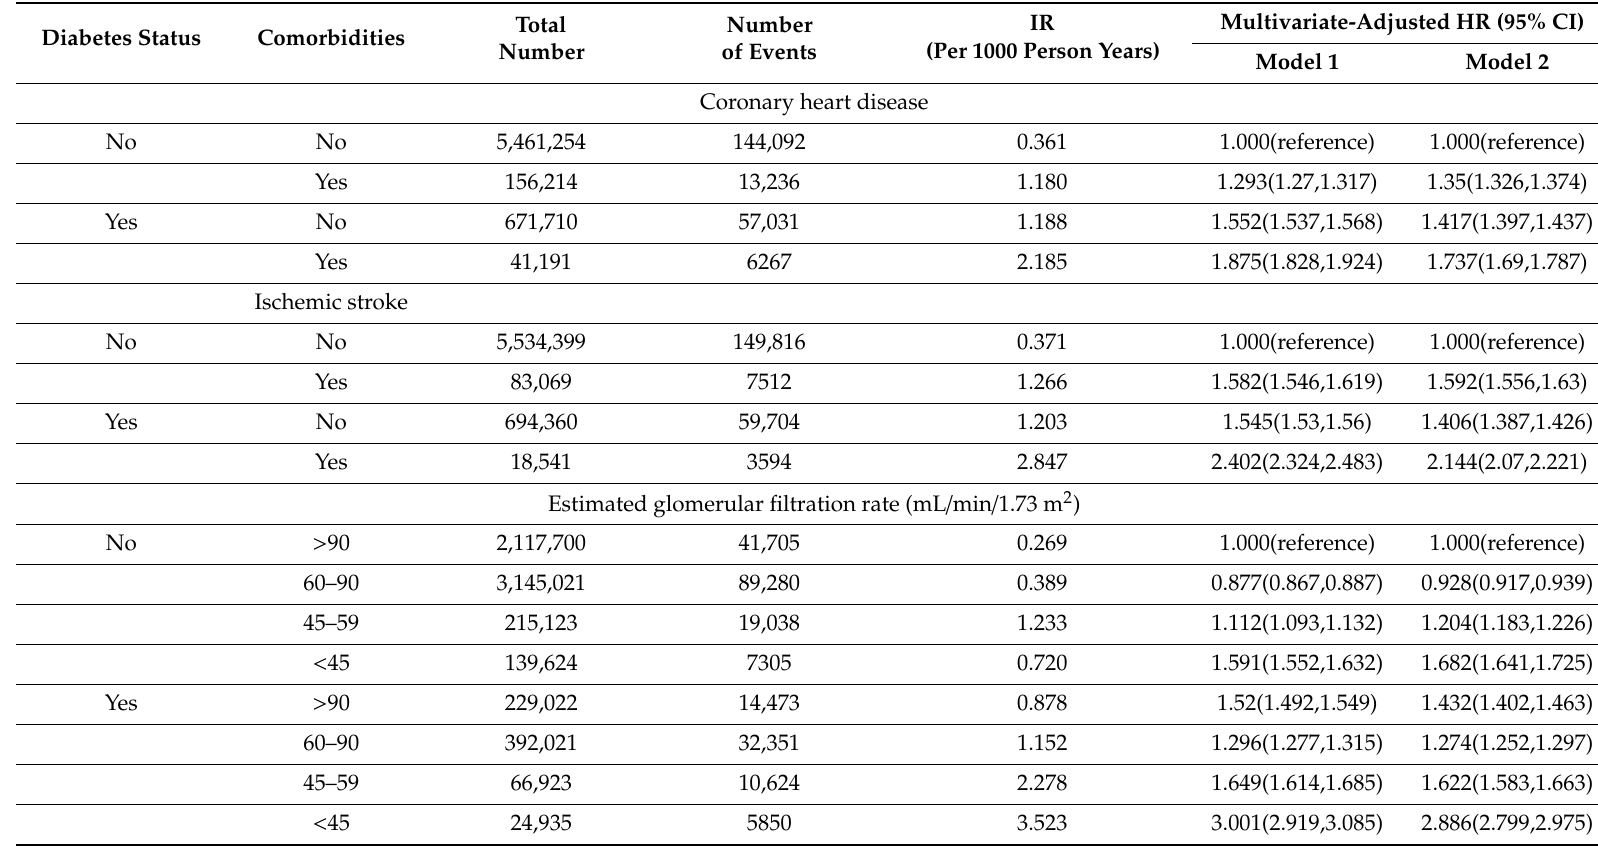
Table 3. The impact of various diseases and risk factors on the association of mortality risk and